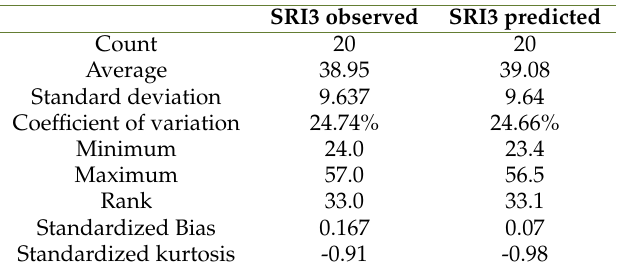
Table 6. Statistical summary of observed and predicted